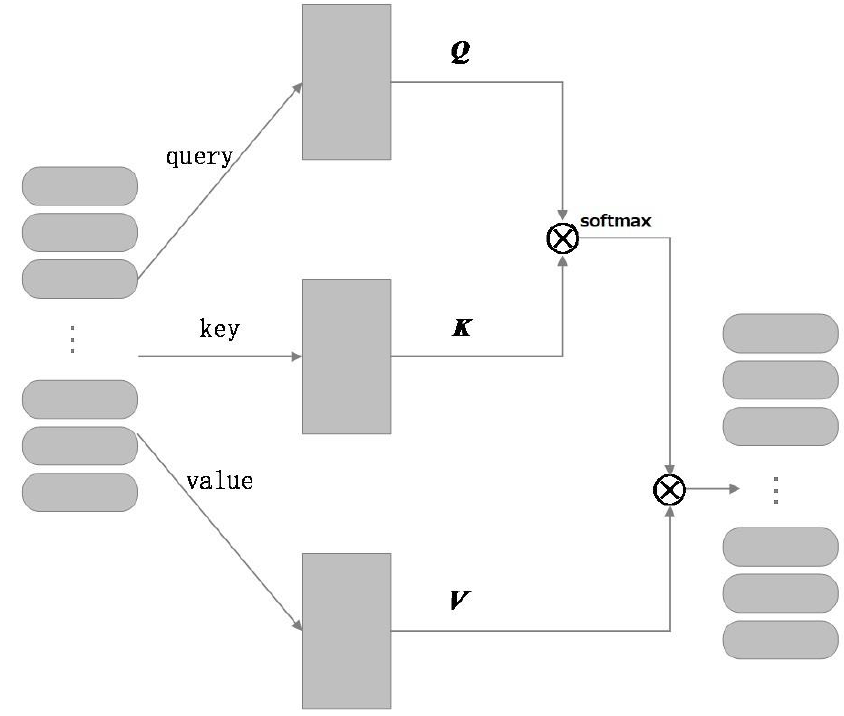
Figure 3. Self‑attention mechanism